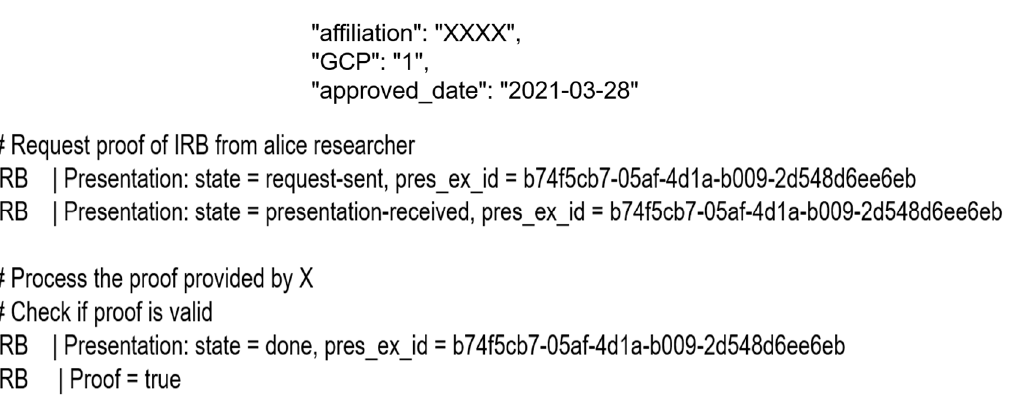
Figure 13. The result of the process the proof by using ZKP.